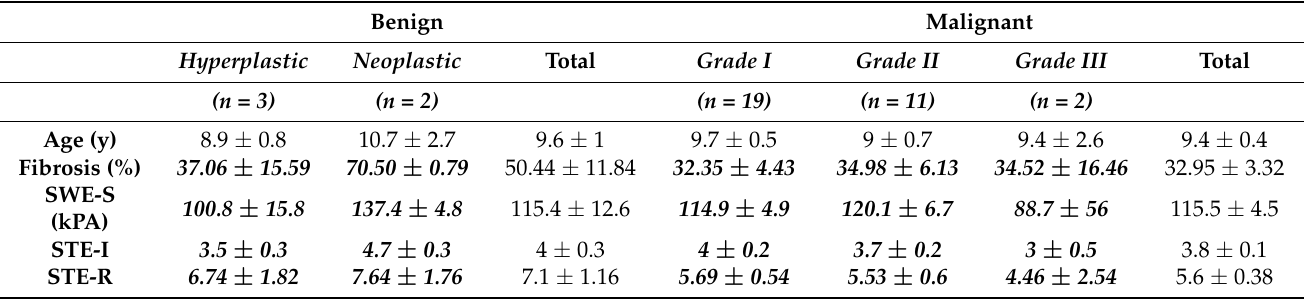
Table 1. Percentage of fibrosis and elastographic parameters in benign (hyperplastic and neoplastic benign lesions) and malignant (grade I, II, and III) canine mammary lesions (n. 38). Benign